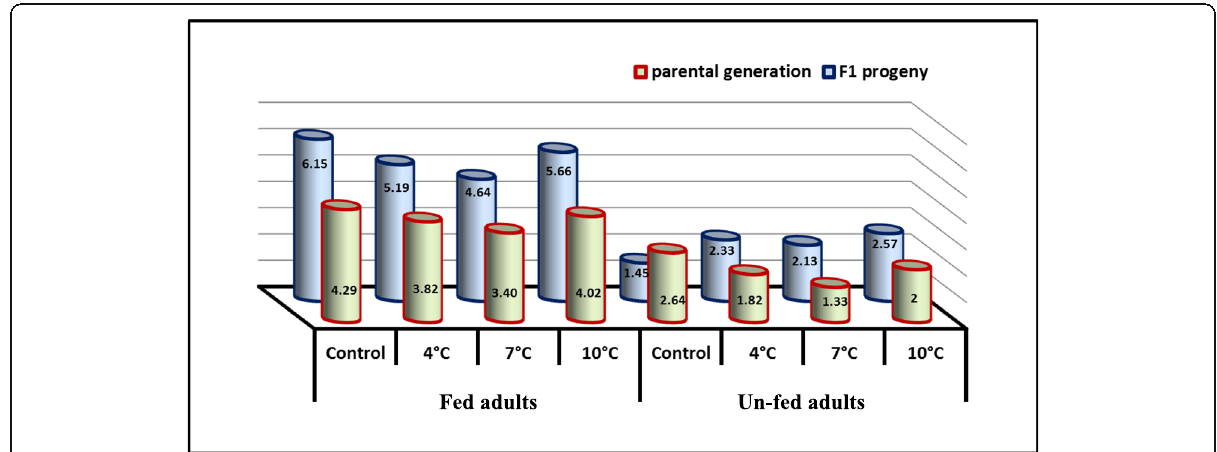
Fig. 3 Mean longevity of Trichogrammatoidea bactrae adults (fed and un-fed) of parental and F 1 progeny after storage of parasitoid pupae at different low temperatures